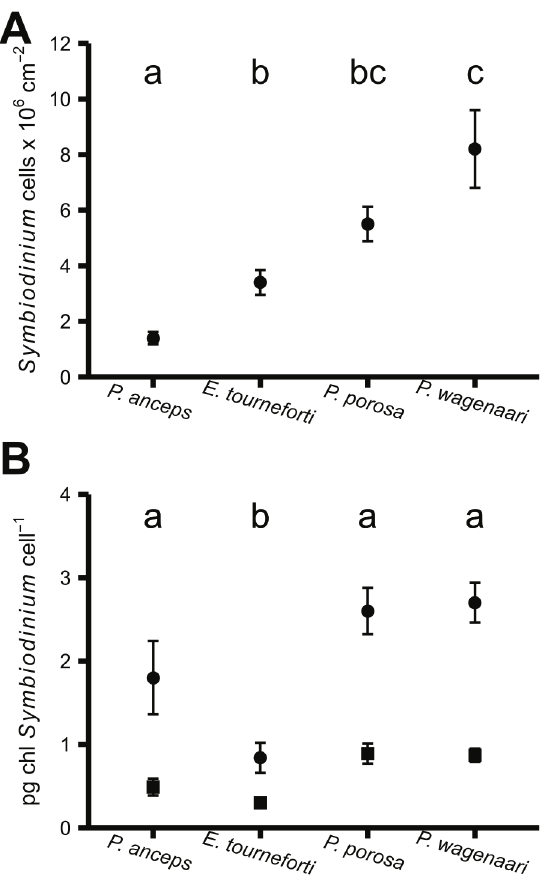
Figure 2. Symbiodinium parameters in four Caribbean gorgoni- an species. (A) Cell densities and, (B) Concentration of chlorophylls a (circles) and c 2 (squares) per Symbiodinium cell. Points represent sample means 6 standard error. Gorgonian species that do not share a letter are significantly different from each other in either density or chlorophyll a per cell ( a =0.05, see Figure 1 for full species names and sample sizes). See Table 3 for significant differences in chlorophyll